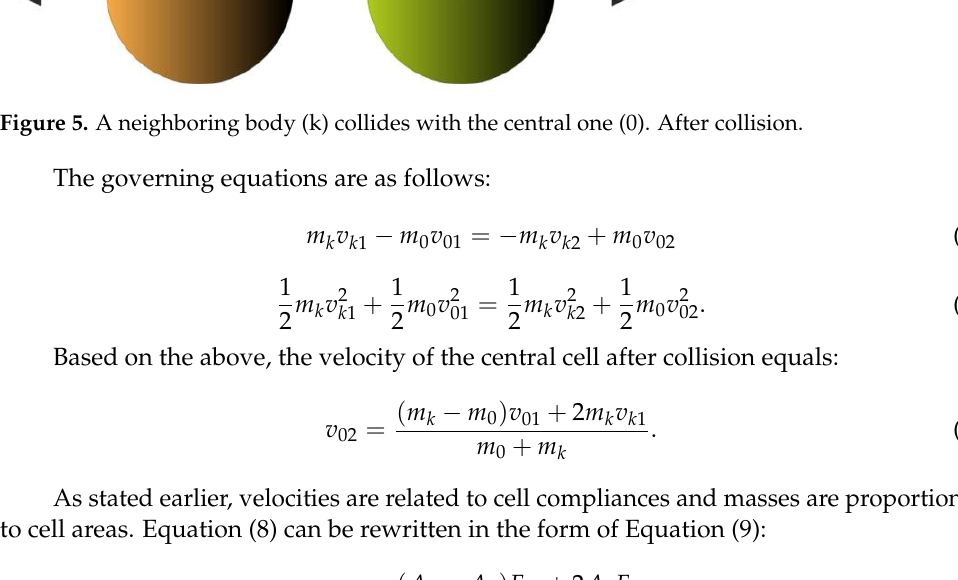
Figure 4. A neighboring body (k) collides with the central one (0). Before collision.